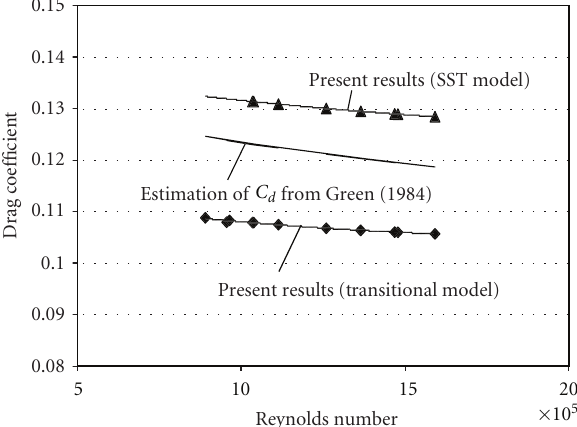
Figure 2: Drag coe ffi cients for Class I probes, including SST model and transitional model results as well as drag coe ffi cients from Green [14].